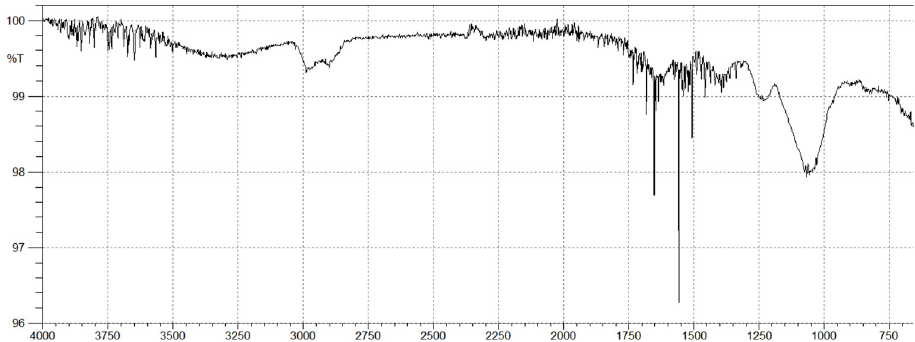
Figure 1. FTIR spectrum of fucoidan isolated from the Lebanese C. sinuosa.